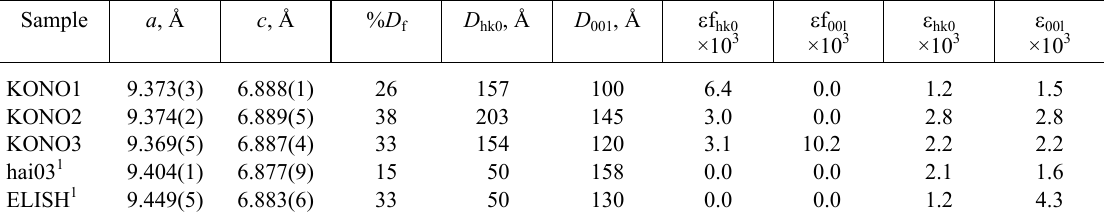
Table 1. Lattice parameters ( a and c ), amount of finer-size-series apatite (% D f ), its dimensions ( D hk0 and D 001 ) and strains for finer series ( ε f hk0 and ε f 00l ) and large-size series ( ε hk0 and ε 00l ) of the studied samples and comparative material Sample a ,